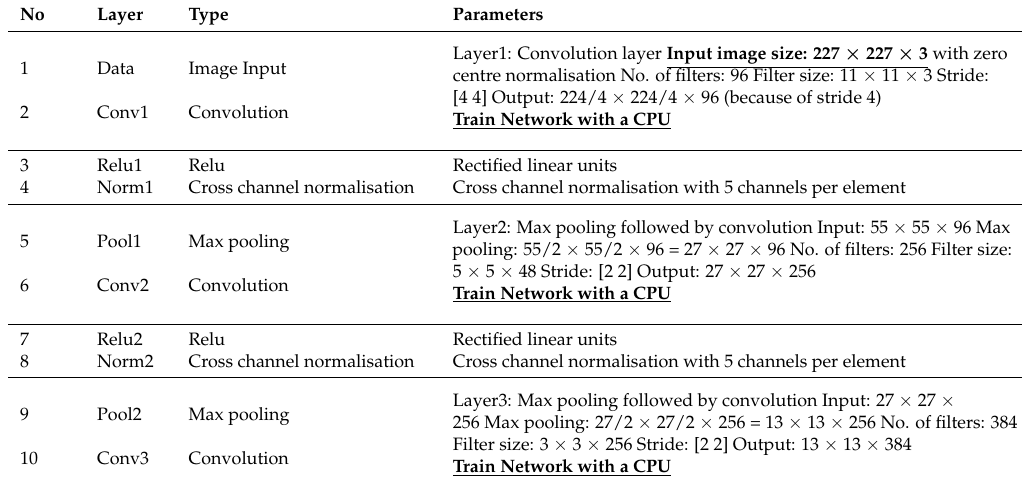
Table 2. AlexNet parameters with fine-tuned network for transfer learning on cornea